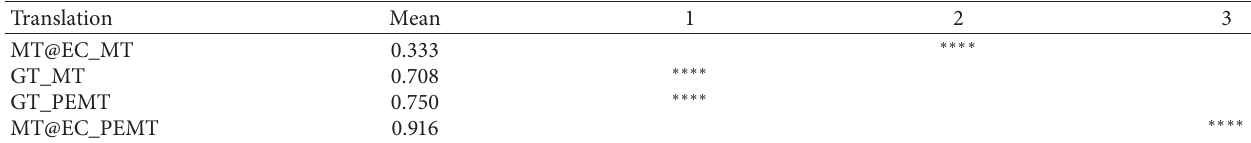
Table 5: Homogeneous groups for incidence of extracted rules in examined translations.